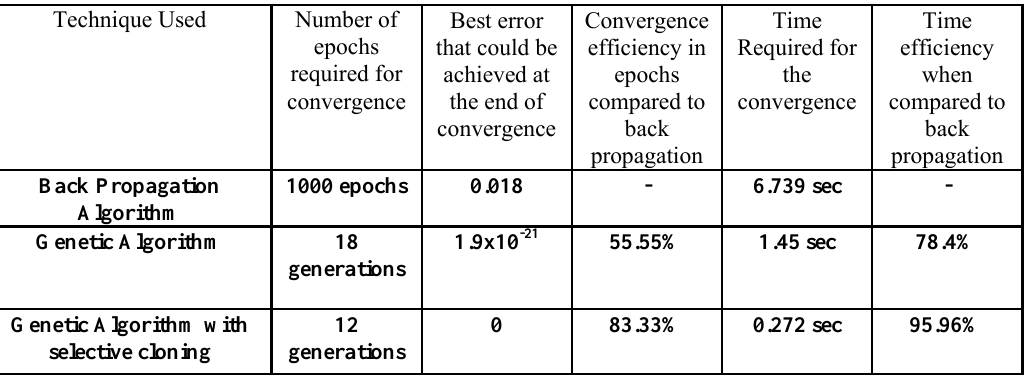
Table 1: Comparison of Selectively Cloned Neural Network, Genetic Algorithm and Conventional Neural Network Back Propagation Algorithm for Iris Data